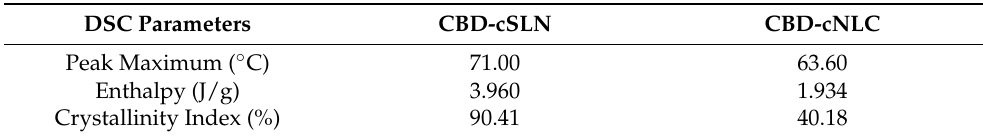
Table 4. DSC parameters for CBD-cSLN and